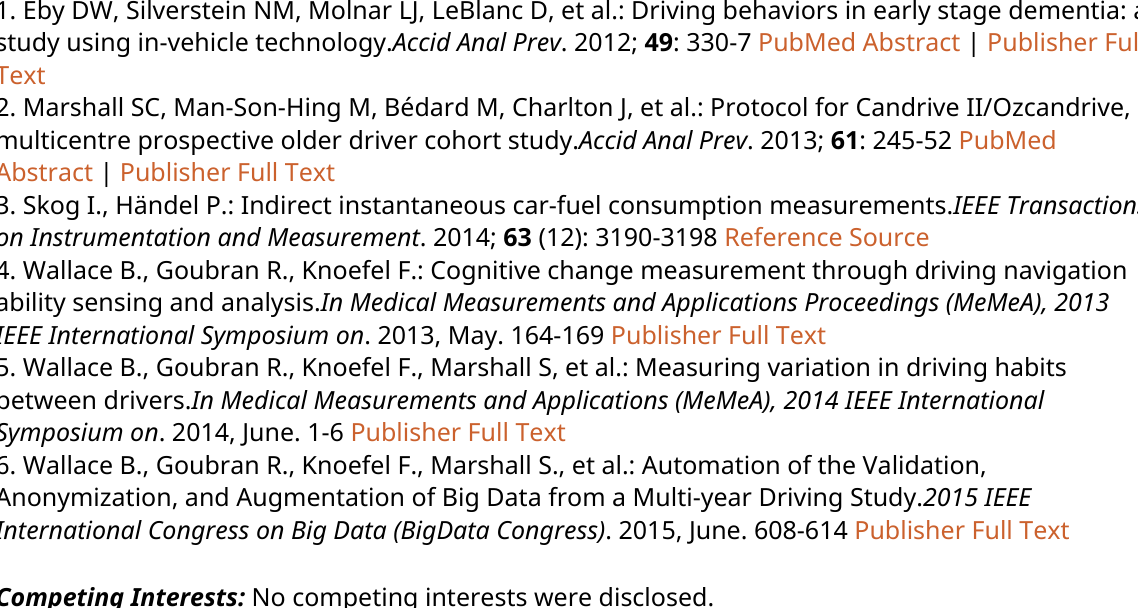
Page 7: Figure 6 is referred to twice – the second time should read Figure 7